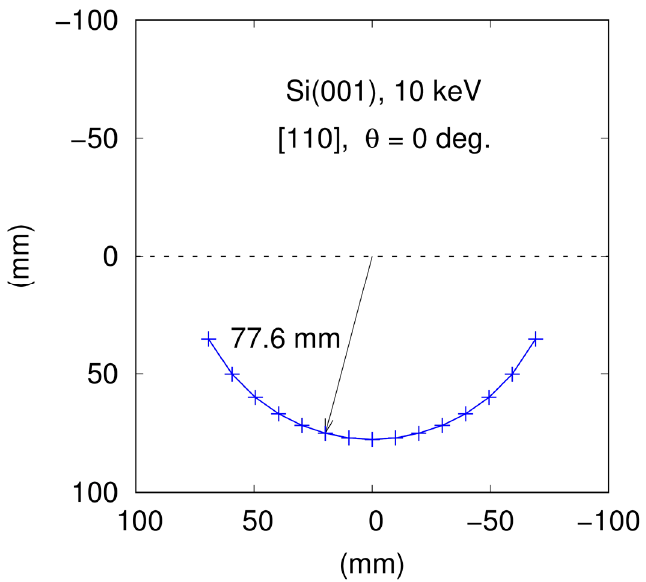
Figure 7. The distribution of the spots for Si(001) for the test data.